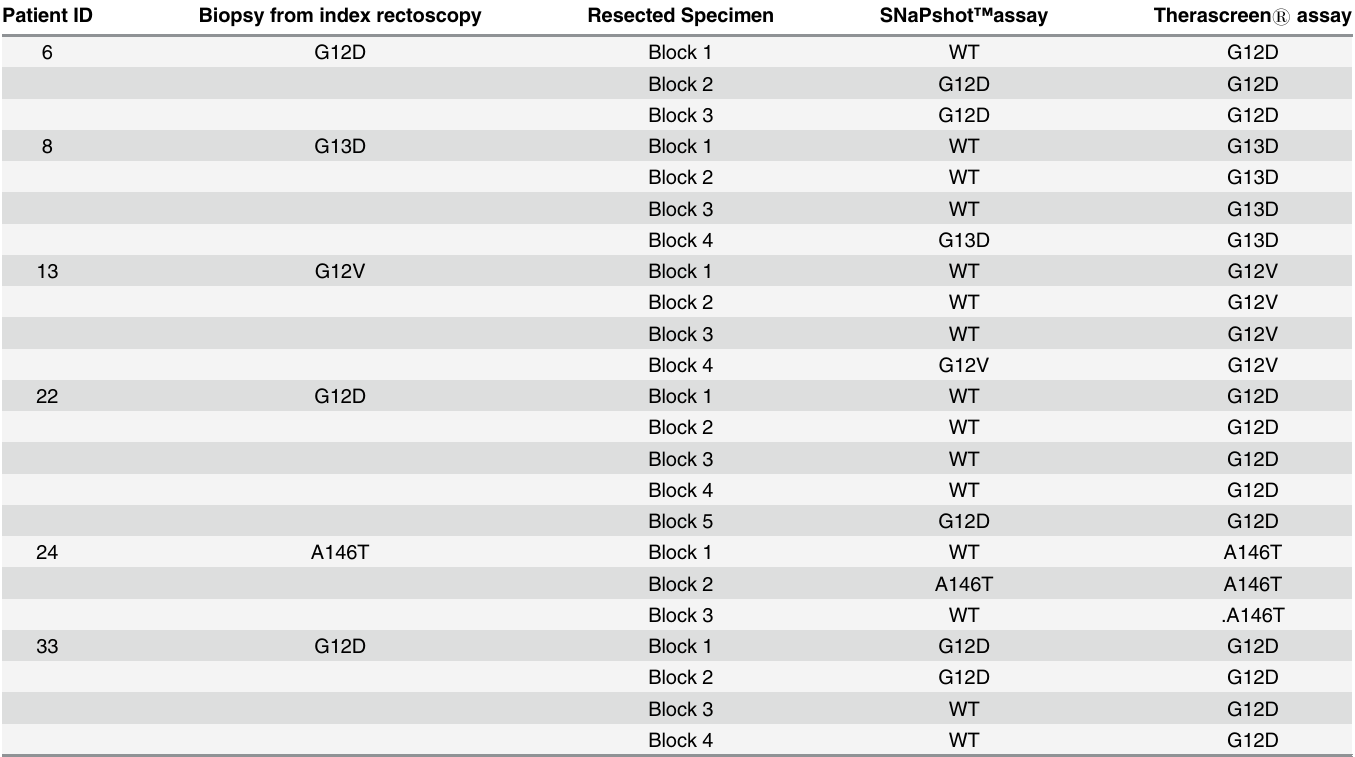
Table 3. Assessment of intratumoral heterogeneity in resected